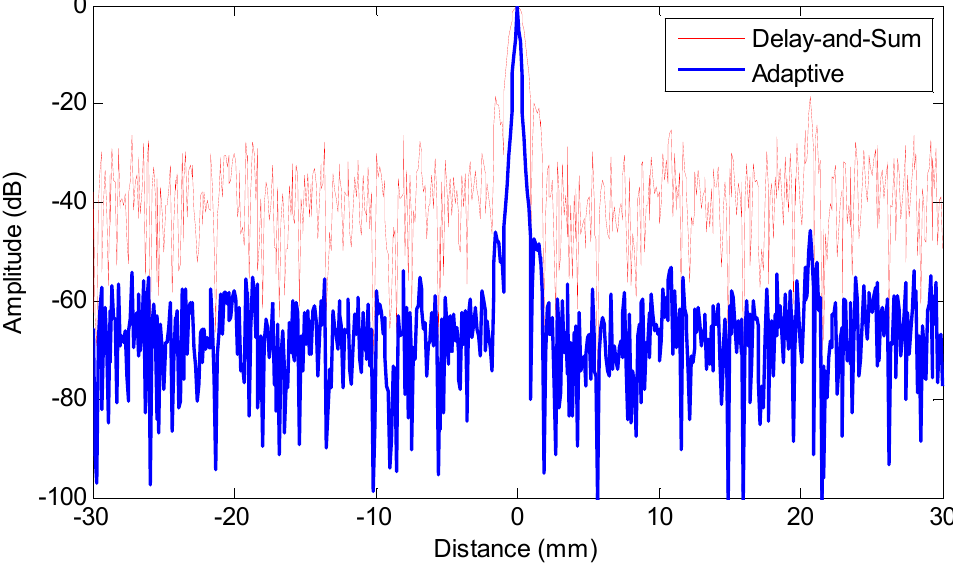
Figure 5. Lateral profiles of simulated images at range of 30 mm. Red solid line: delay-and-sum beamforming, blue bold line: adaptive